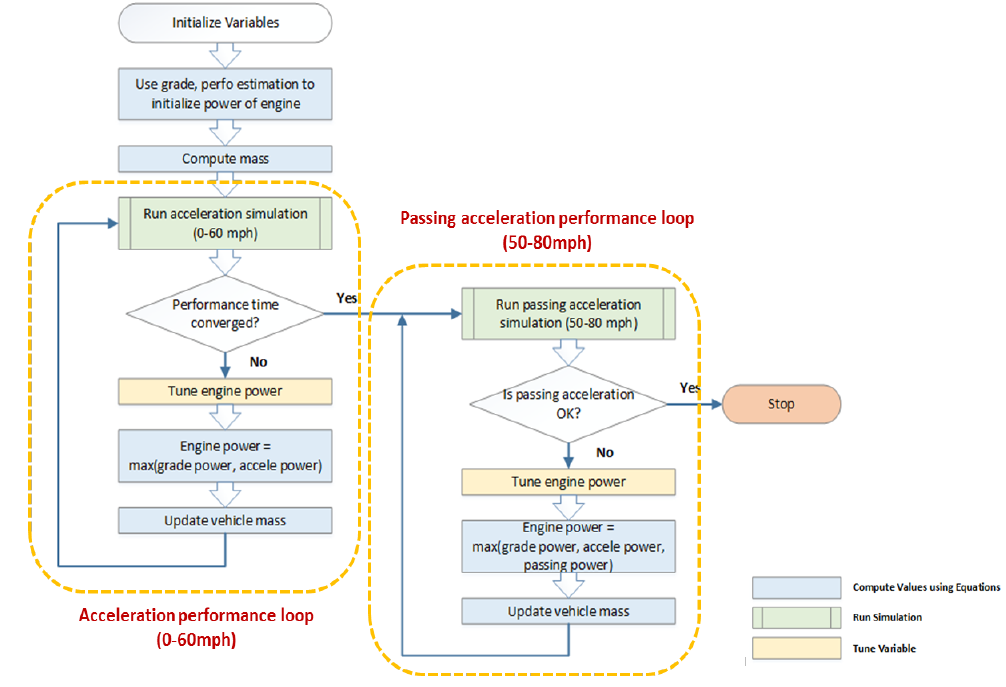
Figure 5. Conventional sizing process.